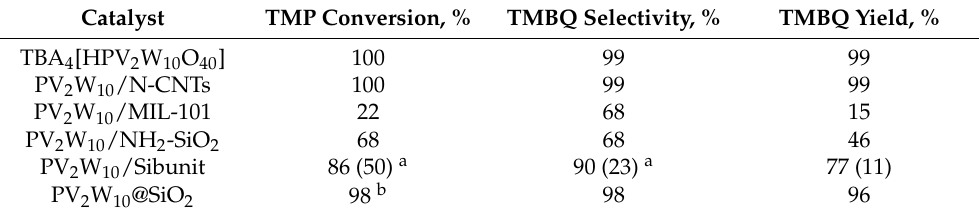
Table 7. TMP oxidation with H 2 O 2 over various PV 2 W 10 -based catalysts. Catalyst TMP Conversion,